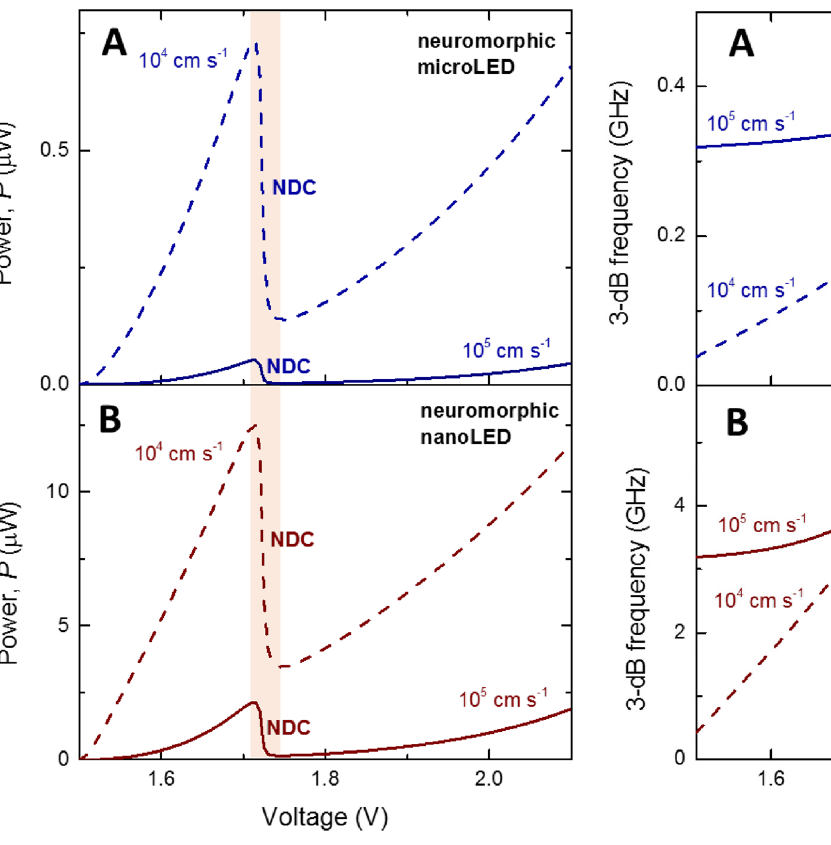
Figure 3: Simulated P - I nonlinear characteristics of the neuromorphic A microLED, and B nanoLED devices. In all curves, the solid lines correspond to a value of surface recombination 10 5 cm s − 1 and the dashed lines to 10 4 cm s − 1 . The vertical shadow represents the NDC corresponding to the voltage region where the DC current decreases which leads to a pronounced N-shape characteristic of the emitted optical power.